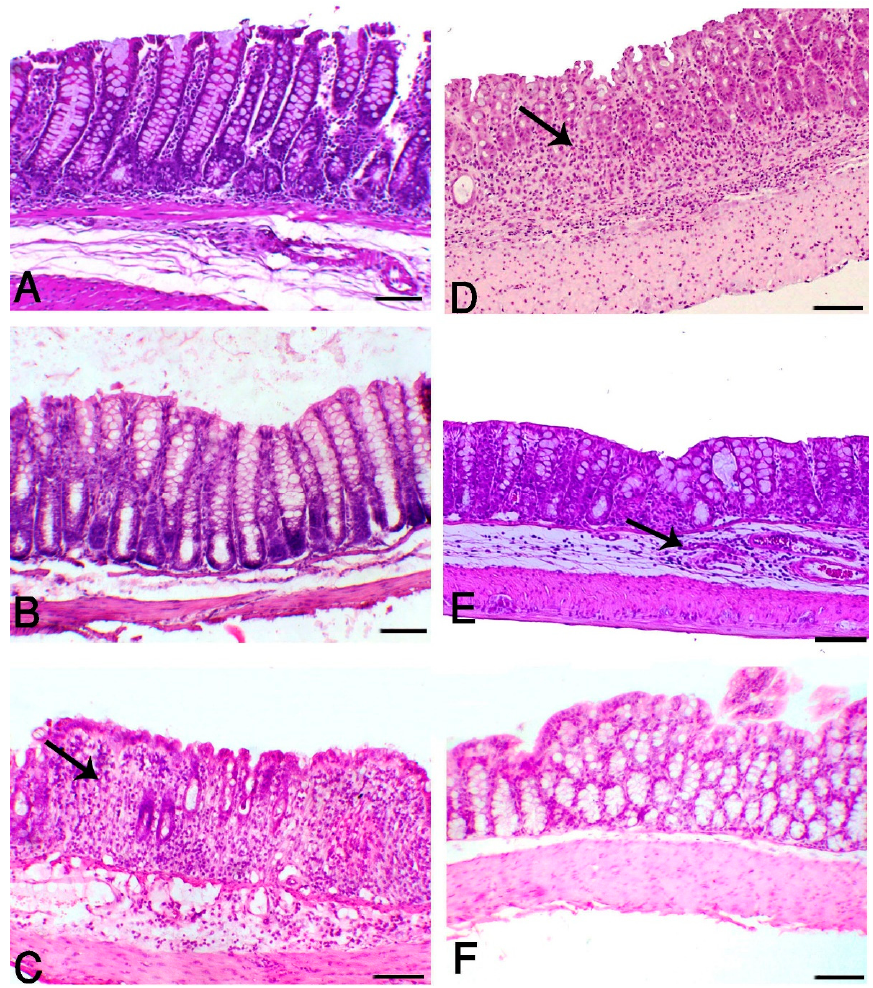
Figure 3. Aloe and/or HK L.137 suppress histopathological alterations in DSS-induced mice. Hematoxylin and eosin (H&E)-stained colon sections from ( A ) Control and ( B ) Aloe/HK L.137-treated mice showing normal mucosal lining without any inflammatory or degenerative lesions; ( C ) DSS-induced mice showing G3 degree of colitis manifested by loss of intestinal crypts and replaced with marked inflammatory cells infiltration (arrow); ( D ) DSS-induced mice received Aloe revealing moderate inflammatory cells infiltration (arrow) towards the submucosa and representing G1; ( E ) DSS-induced mice treated with HK L.137 revealing edema and moderate submucosal infiltration of inflammatory cells (arrow) mostly of G2; and ( F) DSS-induced mice treated with Aloe and HK L.137 showing an increase in normal mucosal lining of G0. (Scale bar = 50 µm). The quantitative histological grades of each segment indicated a decrease in G0 percentage Table 2. Histological score of colitis grades within di ff erent animal groups. (normal tissue grade). The DSS group showed low levels of G0 with markedly increased G3 and G4 inflammation score. DSS-induced animals treated with Aloe and/or HK L.137 demonstrated marked increase in the G0 and G1 score and decreased percentage of G3 and G4 (Table 2). Groups